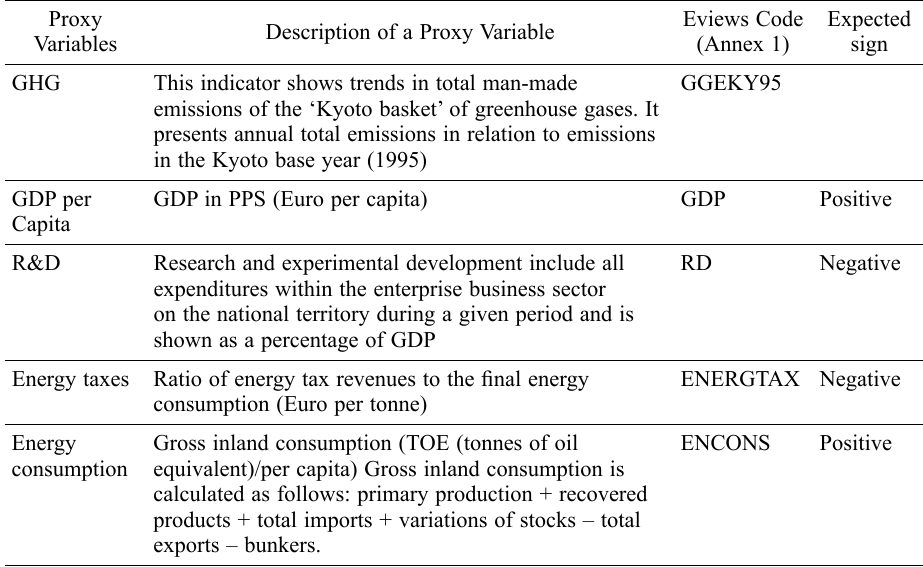
Table 2. Chosen proxy variables affecting